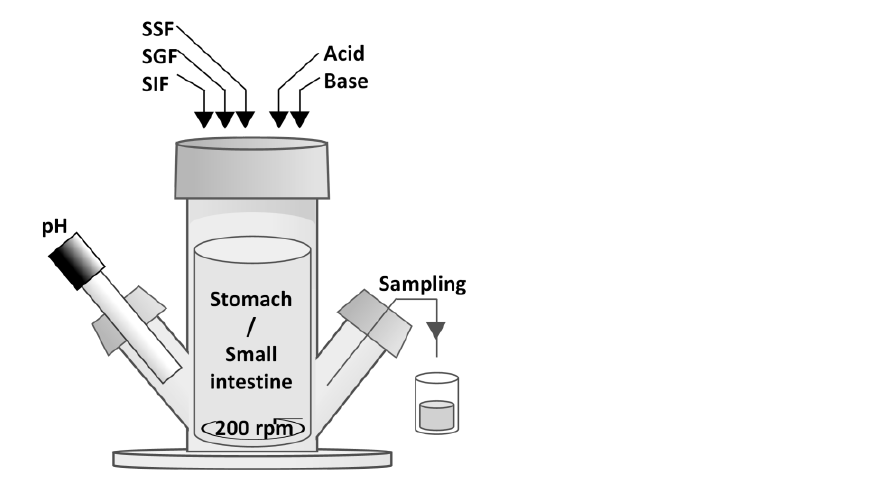
Nutrients 2022 , 14 , x FOR PEER REVIEW Figure 1. Schematic representation of SIM in vitro model of the infant gastrointestinal tract. SSF = simulated saliva fluid, SGF = simulated gastric fluid, SIF = simulated intestinal fluid.